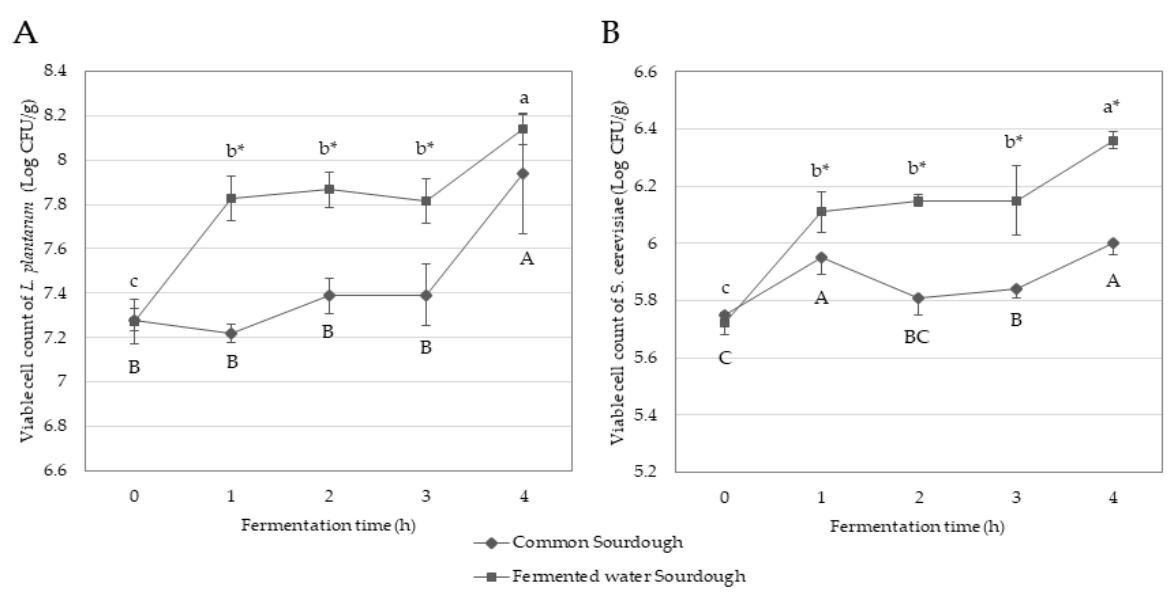
Figure 1. Growth of ( A ) L. plantarum and ( B ) S. cerevisiae in common sourdough and fermented water sourdough throughout fermentation. Results were expressed as mean values of triplicate determinations ( n = 3). Different uppercase and lowercase letters denote significantly different viable cell count of microorganisms in common sourdough and fermented water sourdough, respectively, at different fermentation times using one-way ANOVA, followed by Duncan’s multiple comparison test at p < 0.05, while * denotes significantly different viable cell count of microorganisms between common sourdough and fermented water sourdough detected at the same fermentation time using Student’s unpaired t -test at p < 0.05.